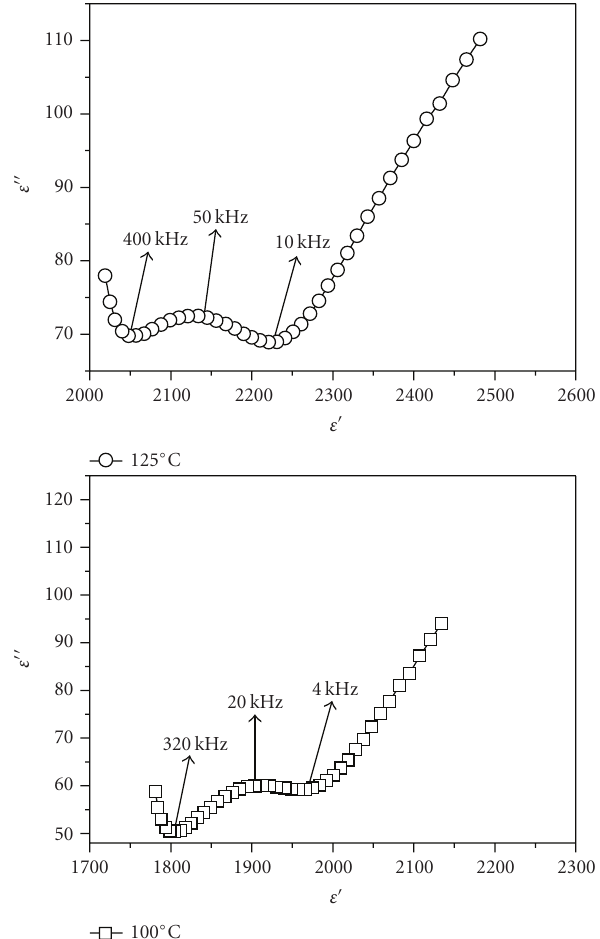
Figure 5: Complex permittivity spectrum (Cole-Cole plot) of PMN-35PT at 100 and 125 ◦